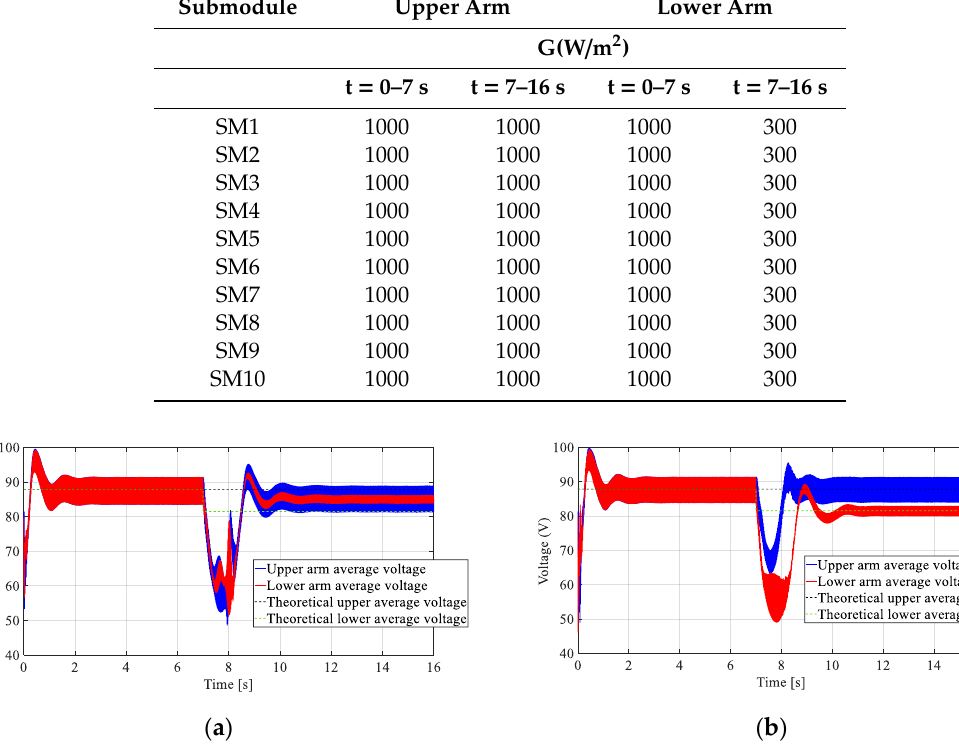
Figure 5. Average arm voltages: ( a ) Centralized MPPT (CMPPT) control; ( b ) Distributed MPPT (DMPPT) control.